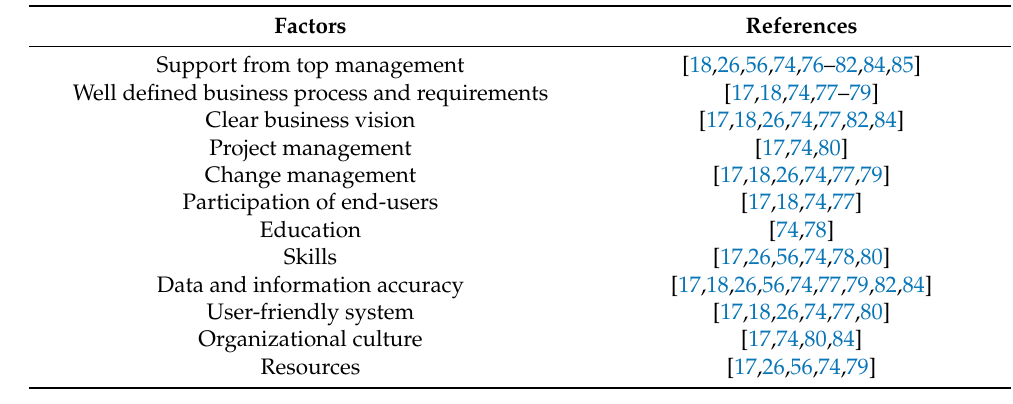
Table 1. Critical success factors for BI